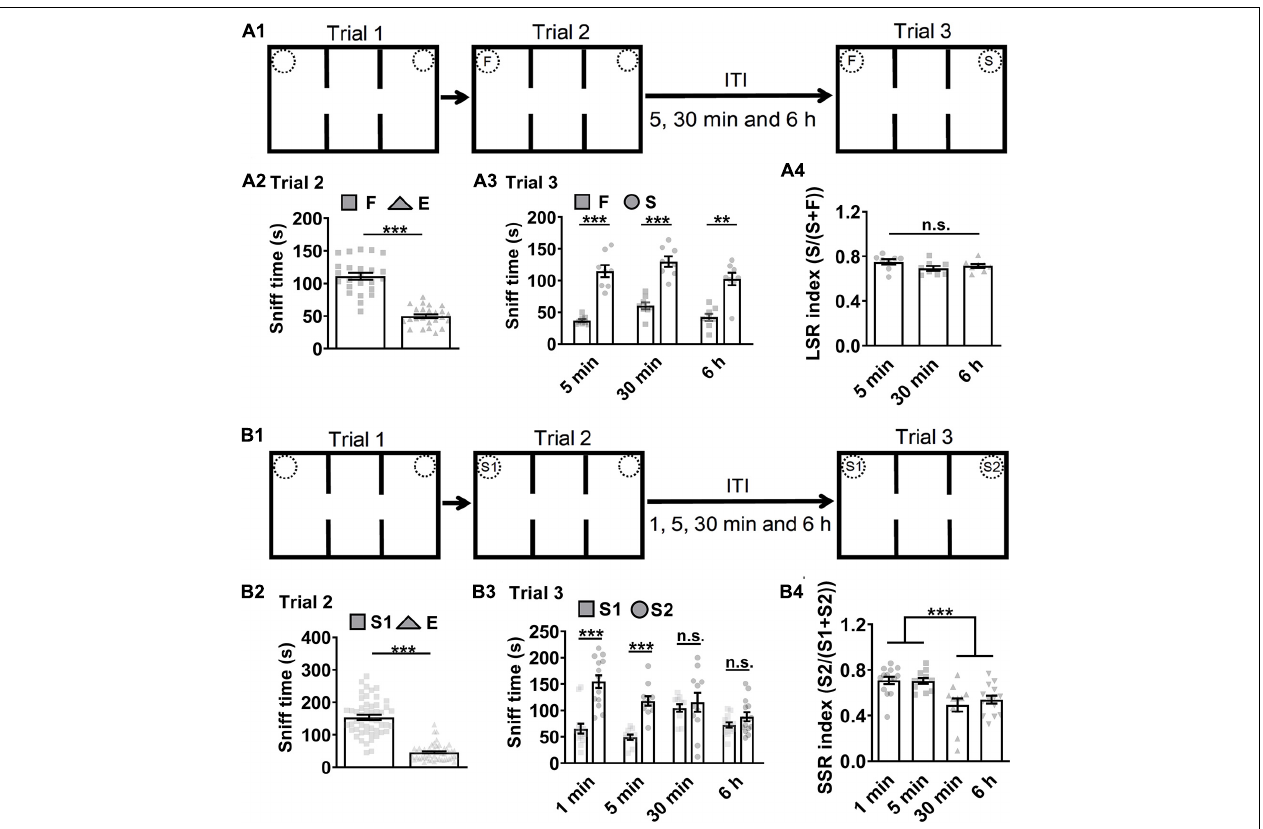
FIGURE 1 | Mice short-term memory monitored in social recognition test. (A1) Schematic of experimental paradigm. ITI, inter-trial intervals; F, a familiar littermate of the subject mice. S, a stranger mouse. (A2) Subject mice exhibited preference (more sniff time) to F than E, suggesting normal sociability in trial 2 by F vs. E ( n =